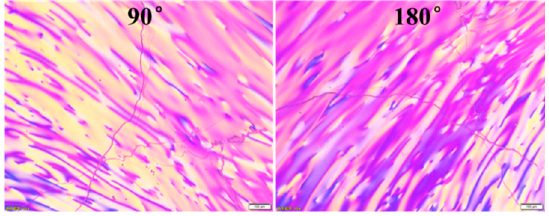
Figure 1. Optical micrographs of FCC-DO mesophase pitch.